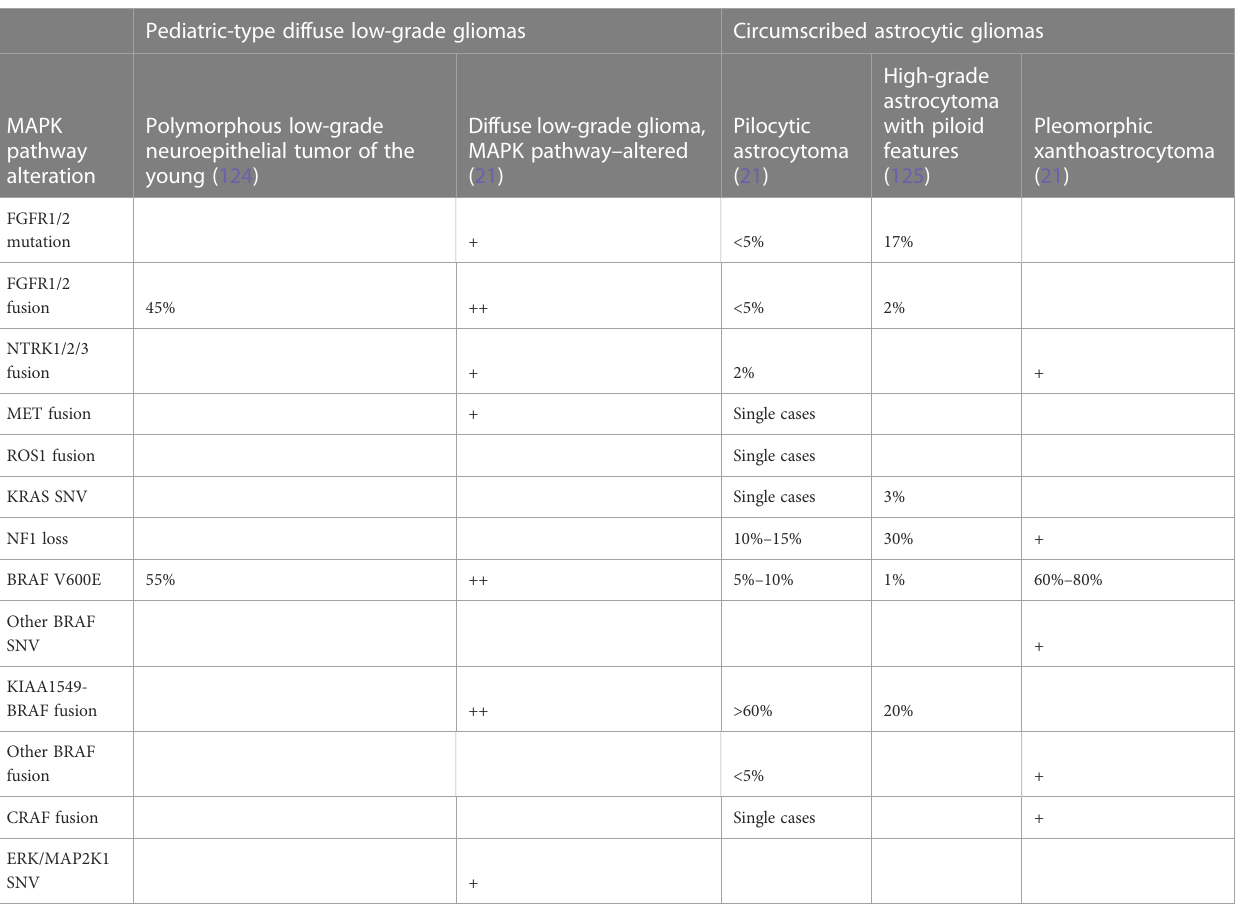
TABLE 1A MAPK pathway alterations by tumor type.